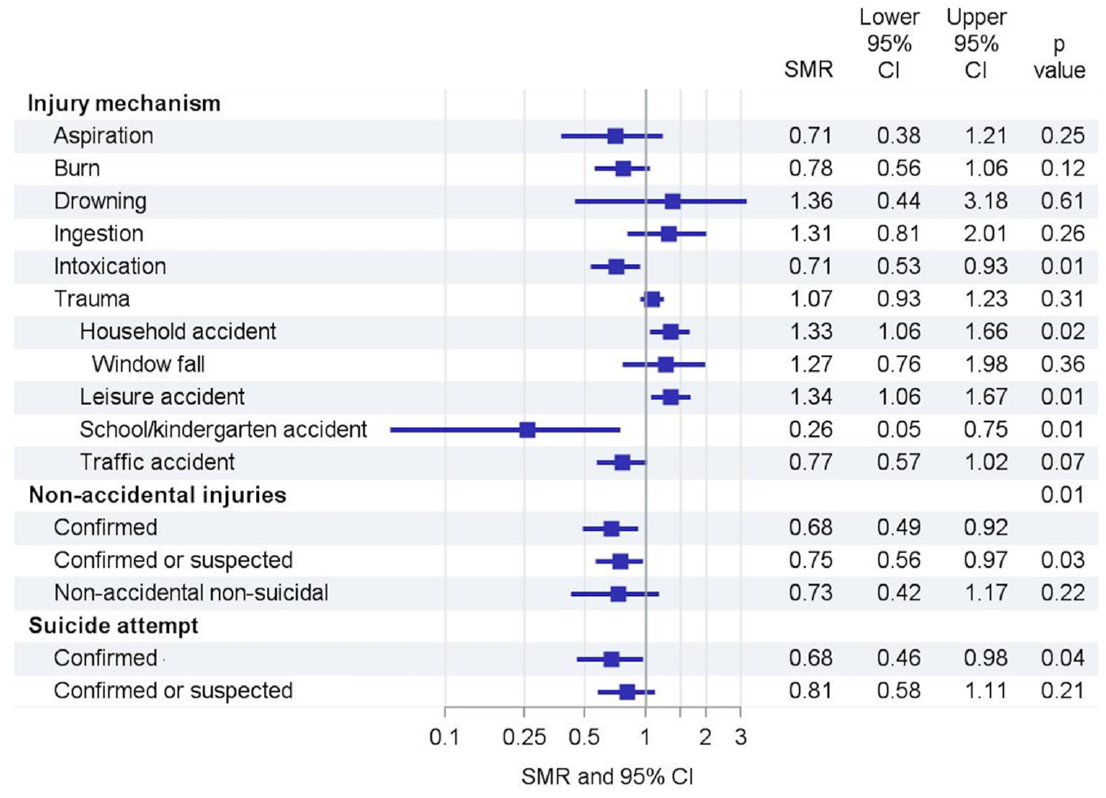
Figure 4. Trends in types of accidents. SMR = standardized morbidity rate, CI = confidence interval.